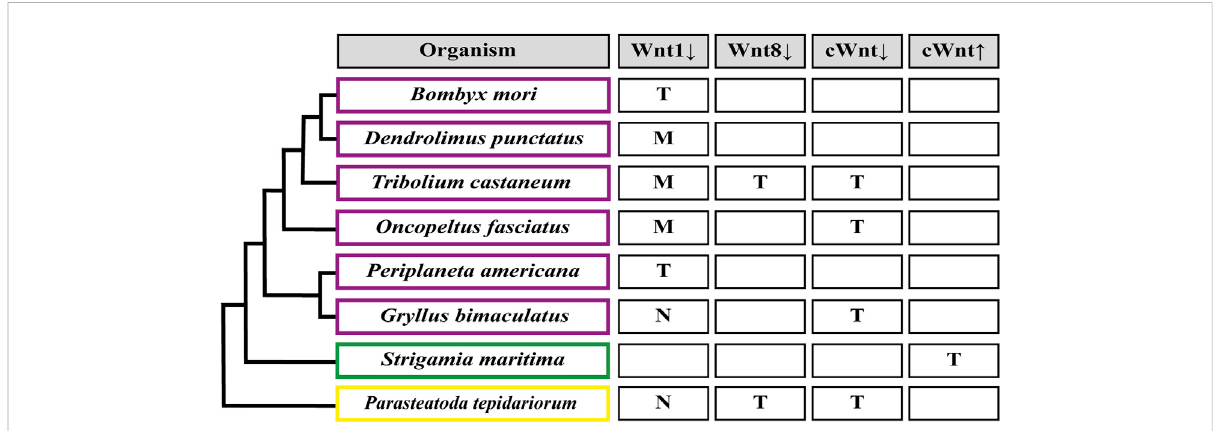
FIGURE 4 Segmentationpatterningphenotypesafter Wnt signaling functionalanalysis.(M)Lossofsegmentboundaries.(T)Truncatedembryo dueto loss ofabdominalsegments.(N)Noeffectonthesegmentationpatterning.Downarrowindicatesinhibition,uparrowindicatesactivation.cWntindicates thefullcanonicalpathway.Anemptyrectanglepointsout theabsence ofthecorrespondingfunctionalstudies inthisorganism.Insects areshownin purple rectangles (Miyawaki et al., 2004; Angelini and Kaufman, 2005; Bolognesi et al., 2008b; Chesebro et al., 2013; Liu et al., 2017; Nakao, 2018; Setton and Sharma, 2021); myriapods in green (Hayden et al., 2015); chelicerates in yellow (McGregor et al., 2008; Setton and Sharma,